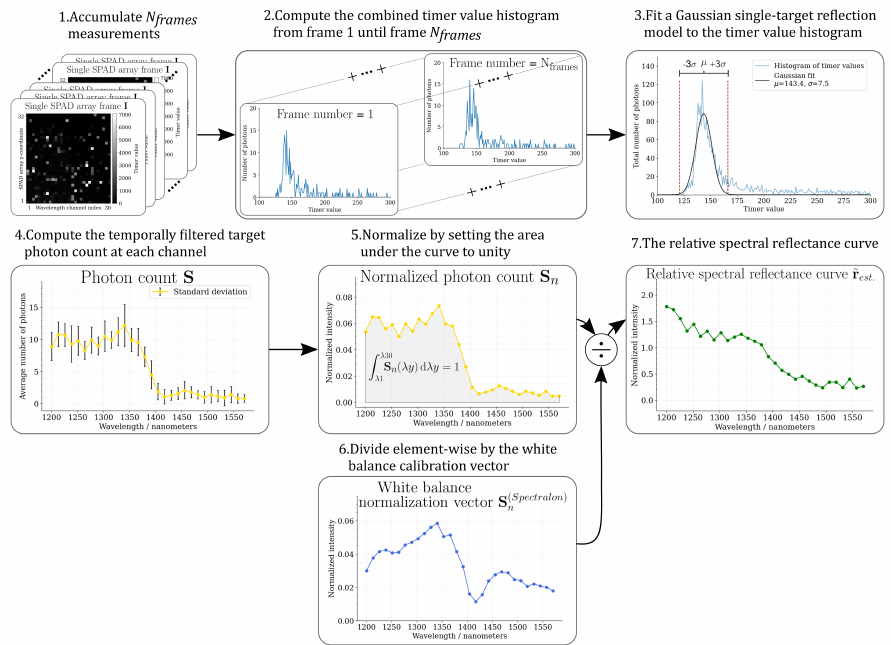
Figure 5. Step-by-step process for computing the relative spectral reflectance curve ˜ r est . The photon counts S are normalized by setting the area under the curve to unity normalization approach, the shape of the relative spectral reflectance curve ˜ r est estimates the material specific spectral reflectance curve r est without requiring the use of an additional calibration step for calculating the absolute reflectance